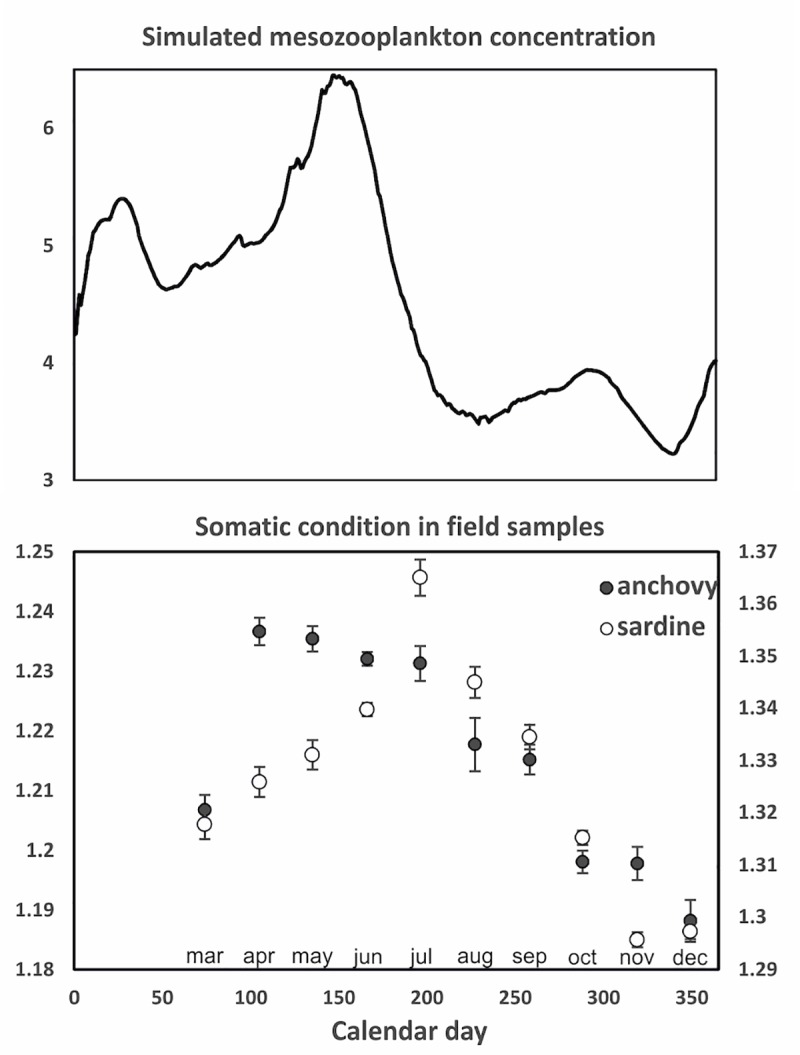
Top panel: Simulated average mesozooplankton concentration (mgC m-3) in the water column (0-100m) against calendar day.Bottom panel: length-adjusted monthly mean weight (somatic condition) of fish samples collected onboard the Thracian Sea purse seine fleet in 2003–2008.